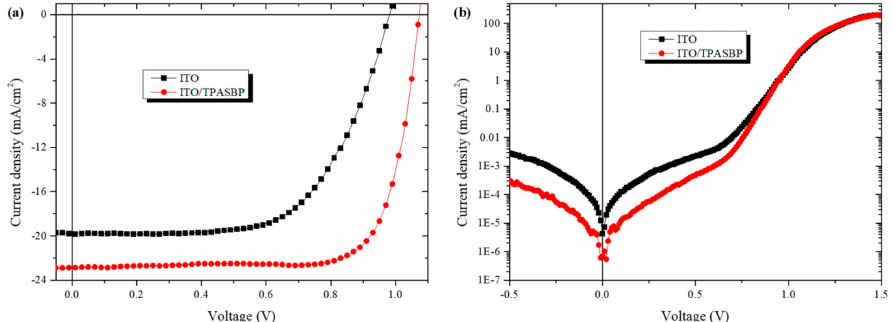
Figure 6. ( a ) Current density-voltage (J-V) characteristics of the best PSCs based on bare ITO and TPASBP-covered ITO under irradiation of 100 mW / cm − 2 , ( b ) dark J-V characteristics of the PSCs with and without